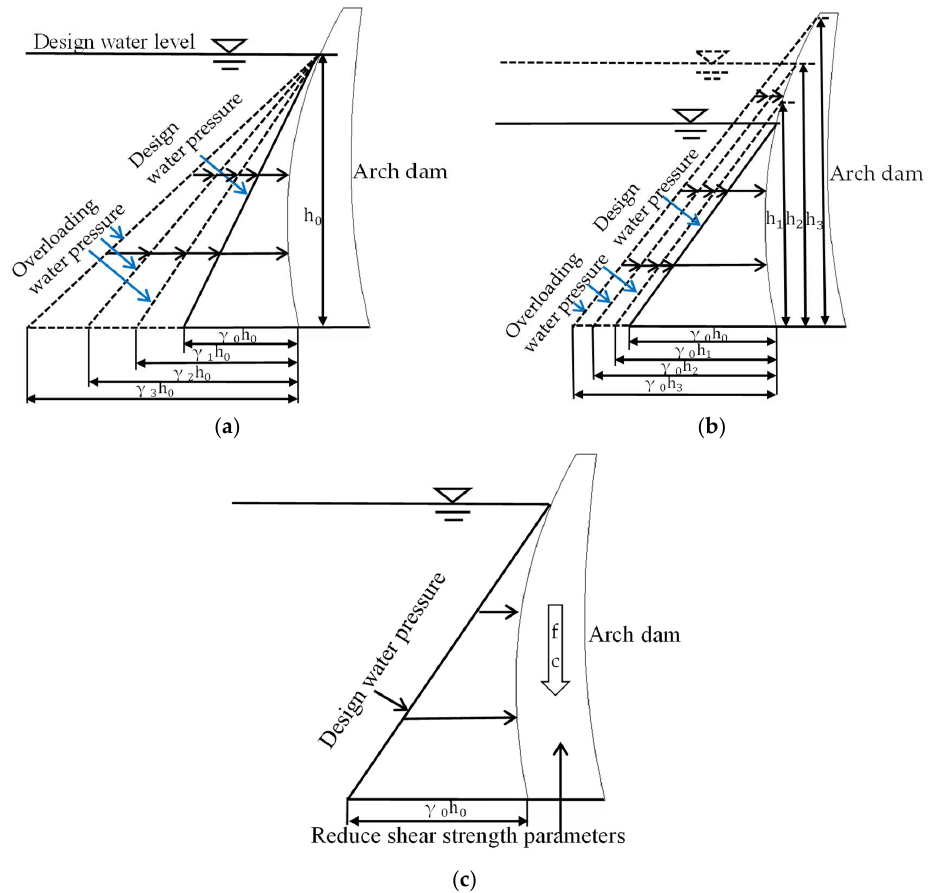
Figure 3. Overloading and strength reduction method. ( a ) Increasing the bulk density of the upstream water; ( b ) increasing the upstream water level; ( c ) strength reduction method.